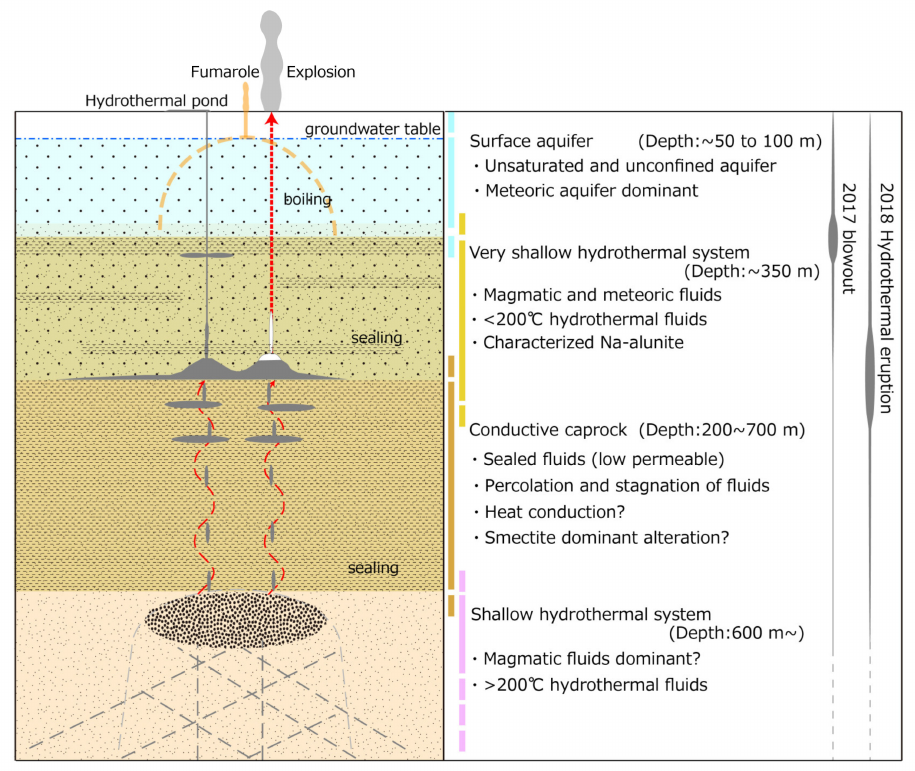
Figure 11. The schematic image of the shallow (ca. 600 m) and very shallow (ca. 350 m) systems beneath Ebinokogen Ioyama Volcano (See more details in Sections 6.1 and